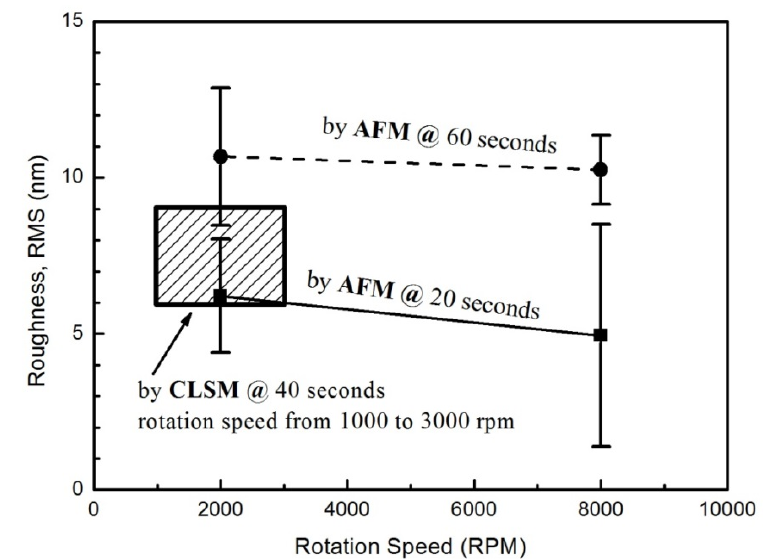
Figure 2. Surface roughness values of spun-on PEDOT:PSS films obtained by AFM in the form of solid symbols with error bars. Also shown is the roughness of spun-on films made at 1000, 2000, and 3000 RPM at 40 s spinning time, measured by CLSM (the hatched rectangle). The CLSM-measured roughness values fall within the two AFM-measured roughness lines, as shown in the graph, showing the adequate accuracy of the CLSM measurements. Field of view for surface roughness measurements is 10 μ m × 10 μ